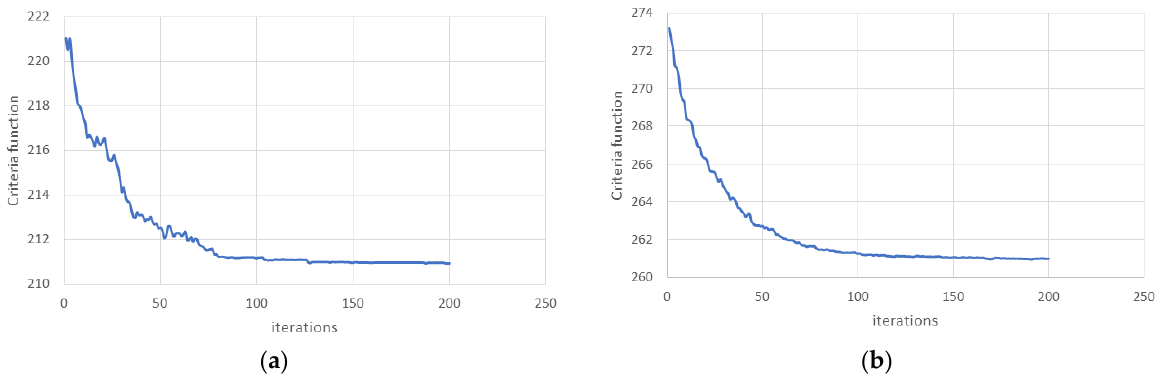
Figure 5. Operation of the ant colony algorithm, ( a ) test settings 24, ( b ) test settings 25.